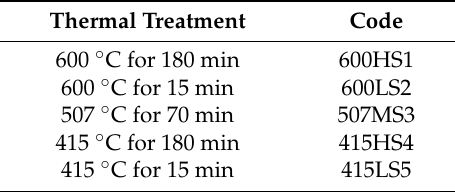
Table 1. Conditions of thermal treatment and code for ZnO thin film